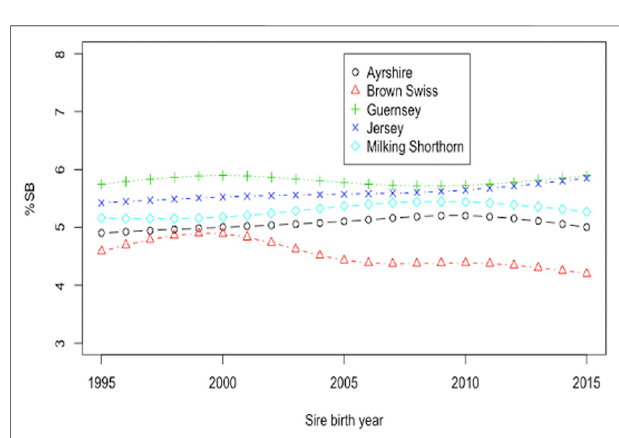
FIGURE 5 | Smoothing spline plot of mean service-sire PTA for the percentageofstillbirths(%SB)bysirebirthyearsince1995in fi venon-Holstein dairy breeds.